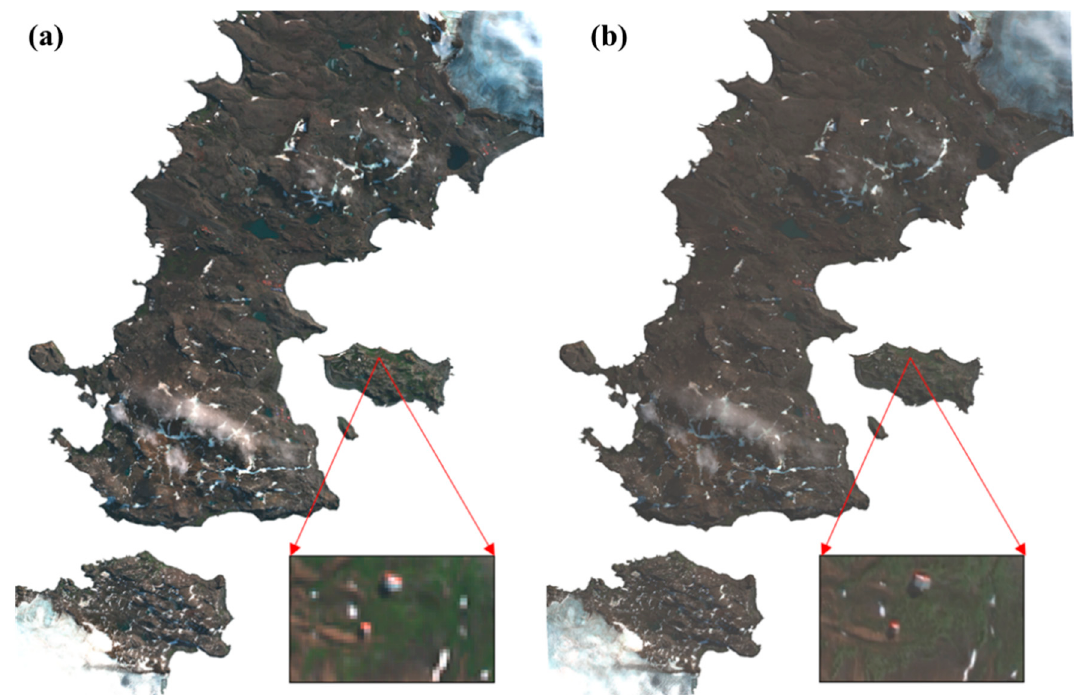
Figure 4. Preprocessing results of the Worldview-2 image coded with red: band 5, green: band 3, and blue: band 2 (true color). ( a ) Image after atmospheric correction; ( b ) enhanced image after pan-sharpening.